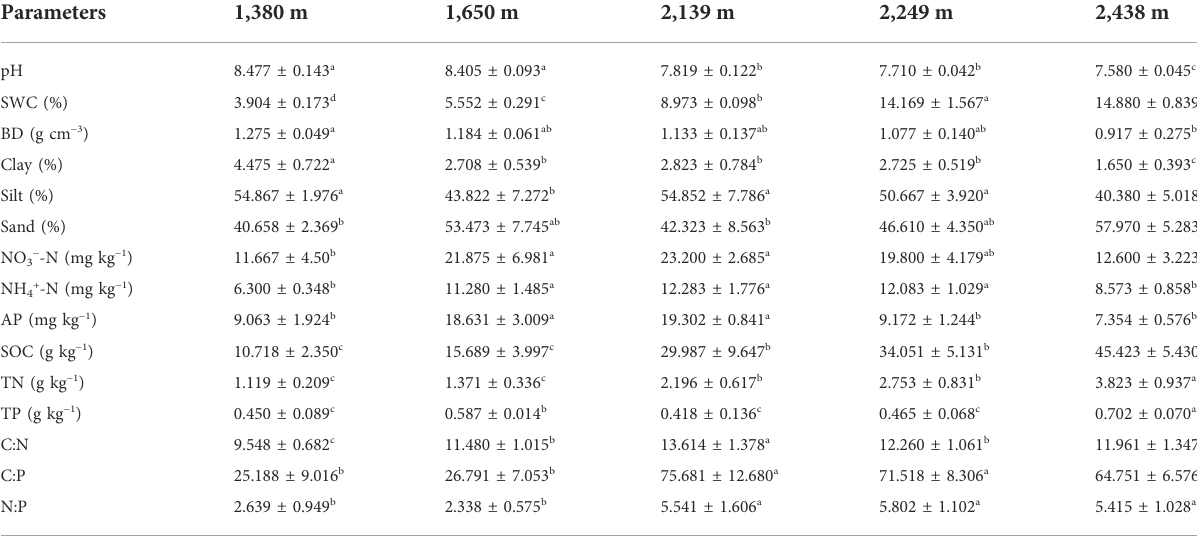
TABLE 1 Physico-chemical properties of the experimental plots in the study area.